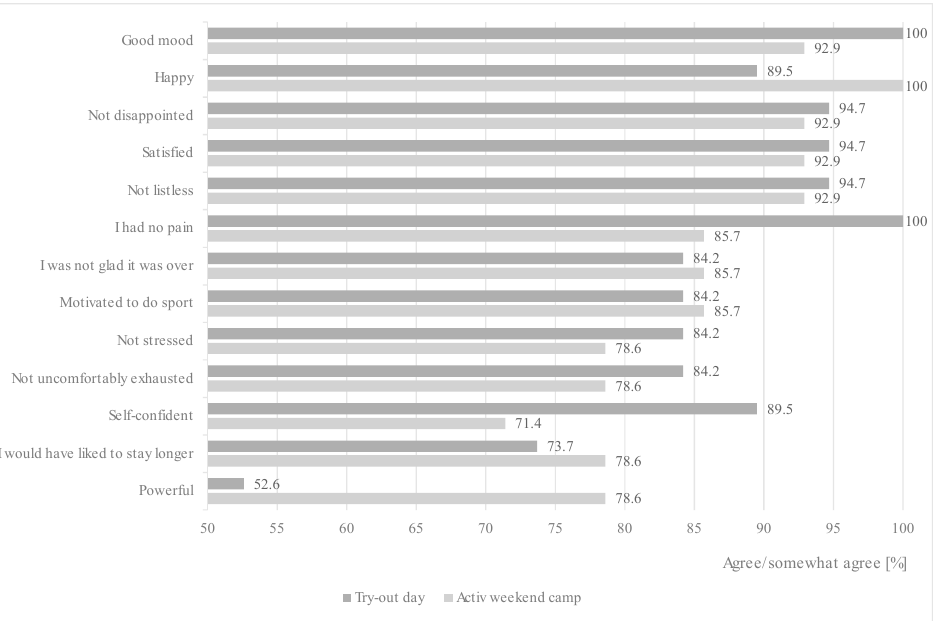
Figure 4. Personal well-being after try-out days and active weekend camps. In the questions about the further exercising, 84.2% (try-out day) and 85.7% (weekend camp) of participants reported about progress in the respective sport (Figure 5); 63.1%